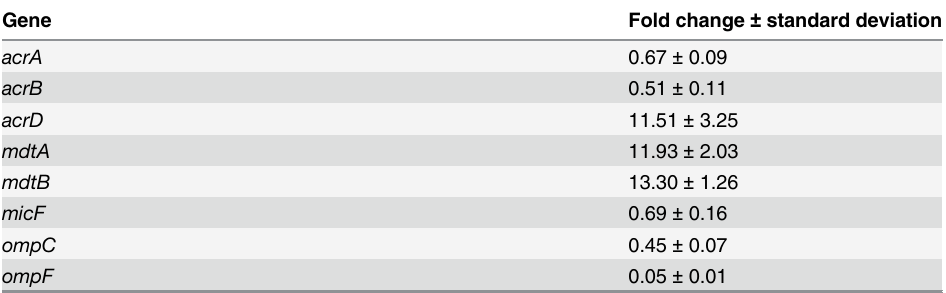
Table 5. Fold change in gene expression of select E . coli genes in the presence of the regulator- containing vector (pCRC03UVRA) versus empty vector (pUVRA28b).